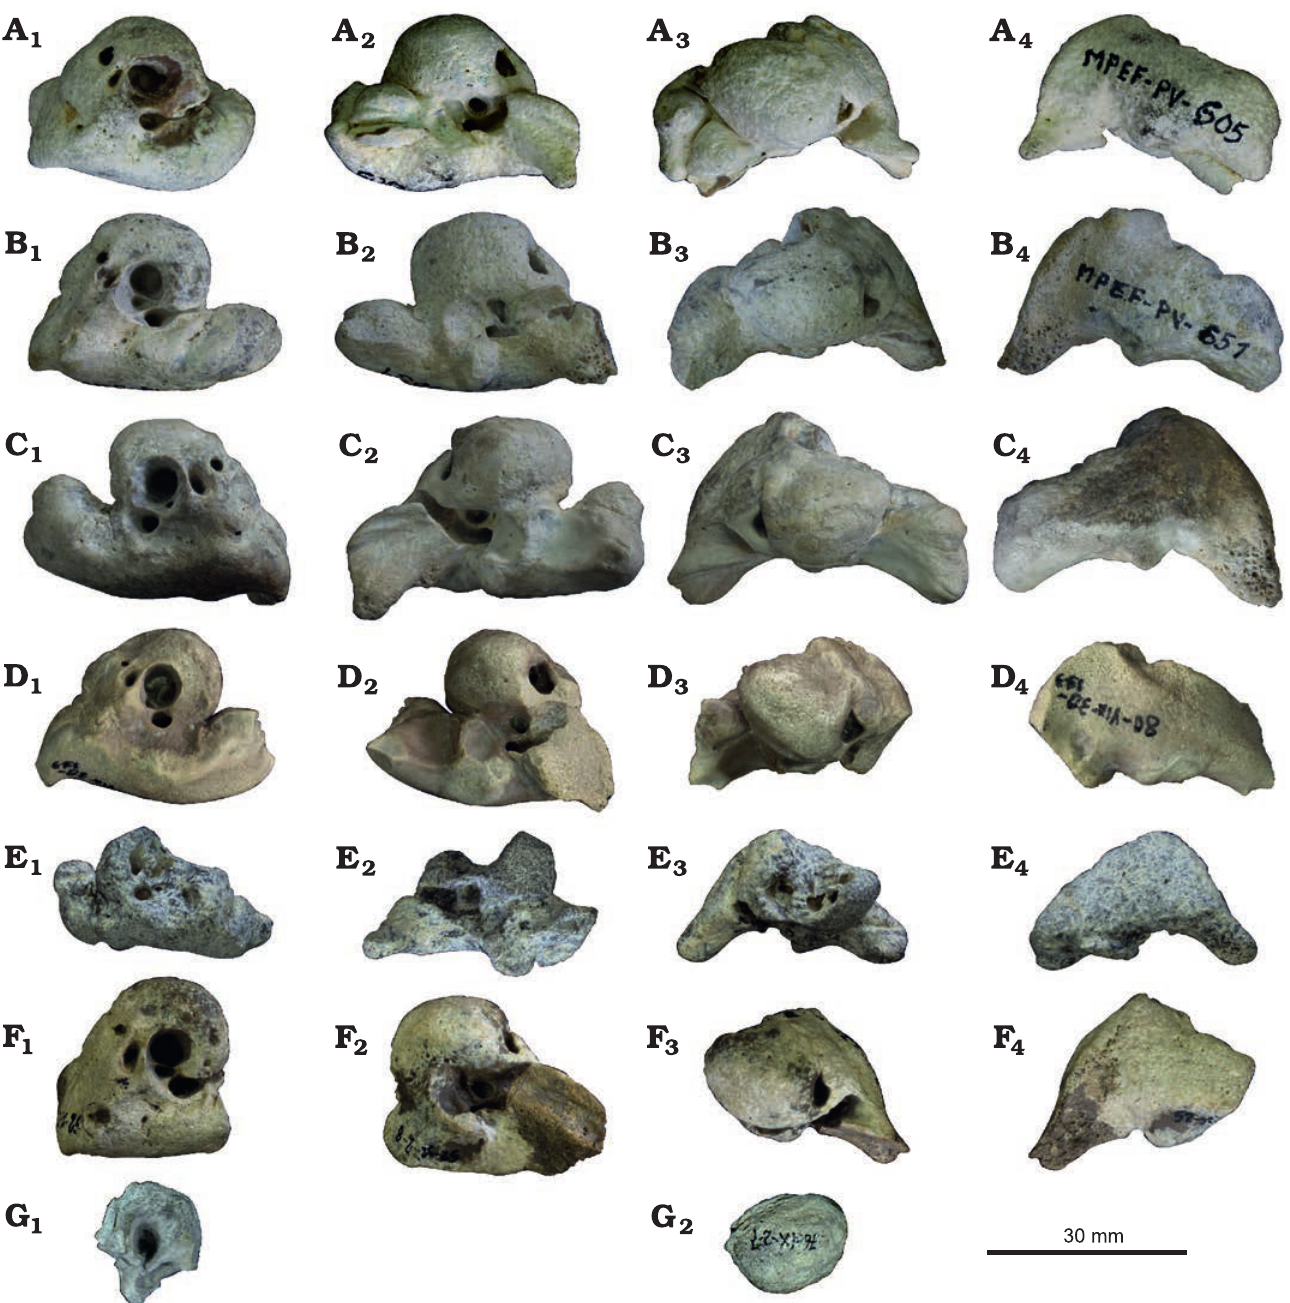
Fig. 4. Isolated periotics of a sperm whale Physeteroidea indet. from the Miocene of Patagonia. A . MPEF-PV-605, right periotic. B . MPEF-PV-651, right periotic. C . MPEF-PV-6098, left periotic. D . MLP 80-VIII-30-133a, right periotic. E MLP 80-VIII-30-133b, left periotic. F . MLP 52-X-2-8, right periotic. In dorsal (A 1 –F 1 ), ventral (A 2 –F 2 ), medial (A 3 –F 3 ), and lateral (A 4 –F 4 ) views. G . MLP 56-IX-2-7, fragmentary periotic in dorsal (G 1 ) and medial (G 2 )